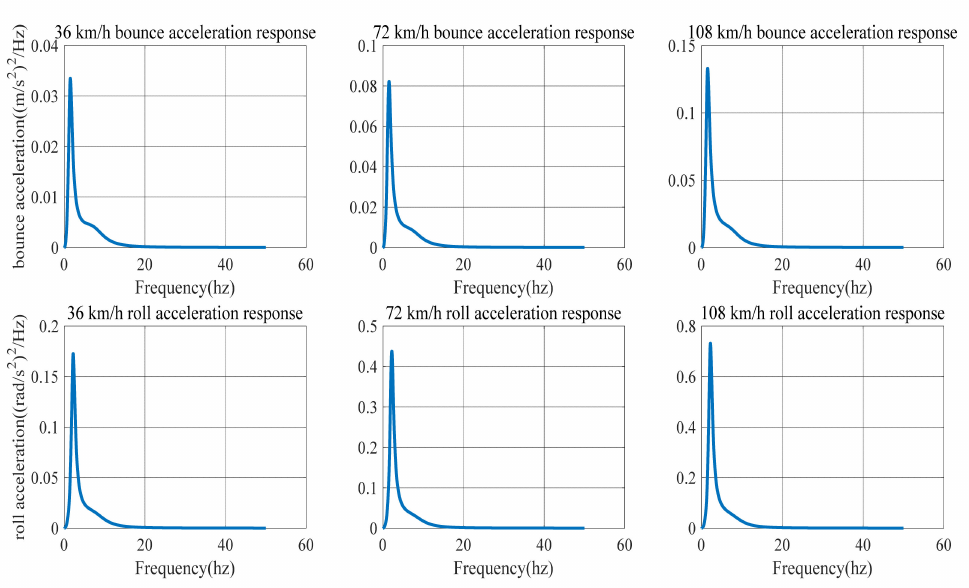
Figure 7. The power spectrum density of the acceleration of an HIIRS-equipped vehicle when driven at 36, 72 and 108 km/h on Class-B road. When c = 256 × 10 − 8 (C-level road) and the vehicle speed is 36, 72 and 108 km/h, the power spectrum density of bounce acceleration and the power spectrum density of roll acceleration of the HIIRS system are shown, respectively, in Figure 8.